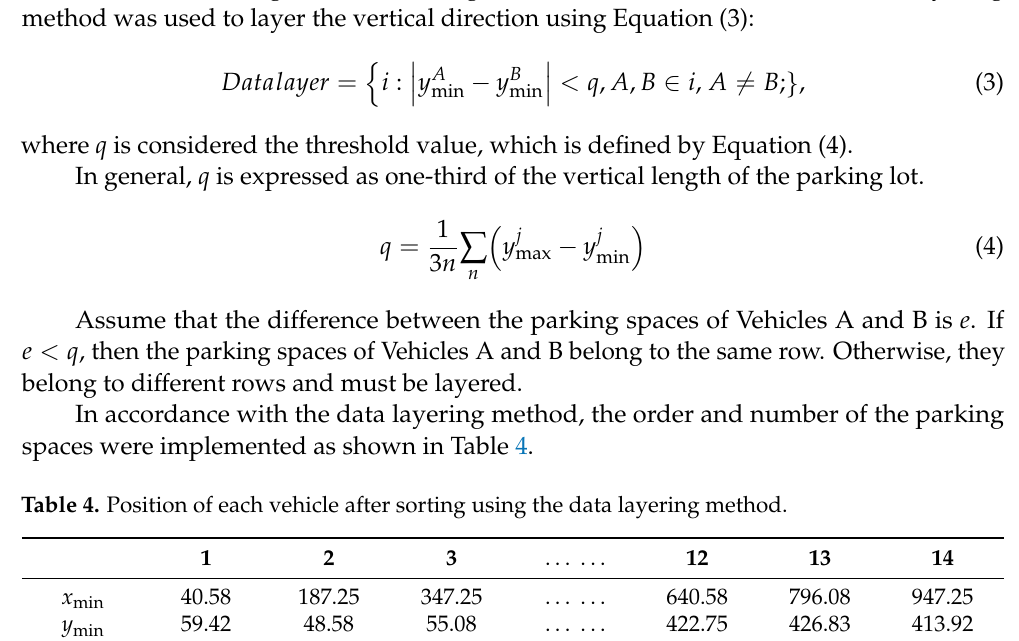
Table 4 indicates that the data layering method divided the data into two layers—namely, layers 0 and 1. In accordance with the position of each vehicle after sorting with the data layering method, each vehicle number was determined as shown in Figure 6. Ultimately, we were able to determine the order and number of each parking